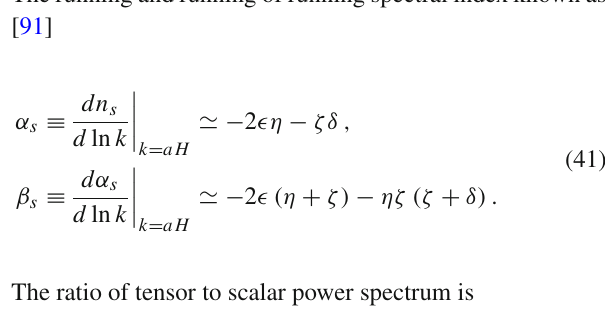
The kinetic term of (36) is similar the no-scale models [37]. Canonically normalizing the scalar field as φ =